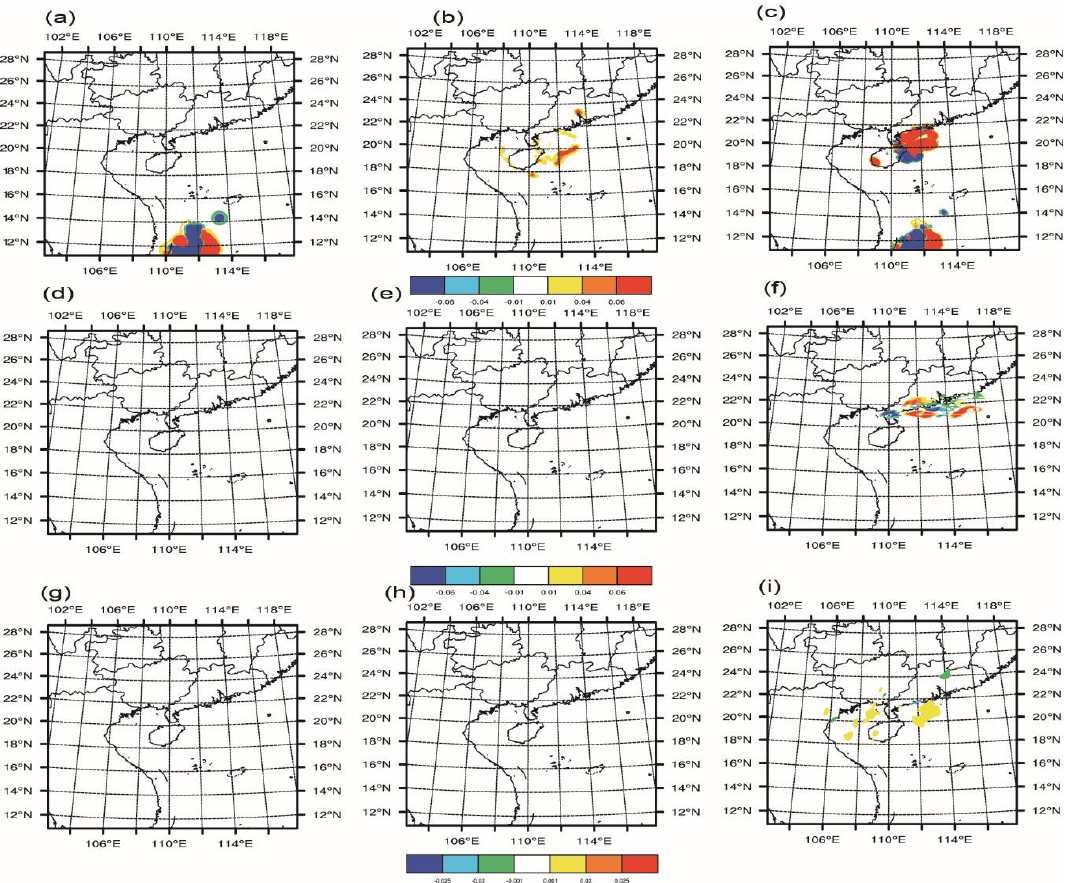
Figure 6. The q r (first row), the q s (second row), and the q g (third row) water path (shaded; units: g/kg)